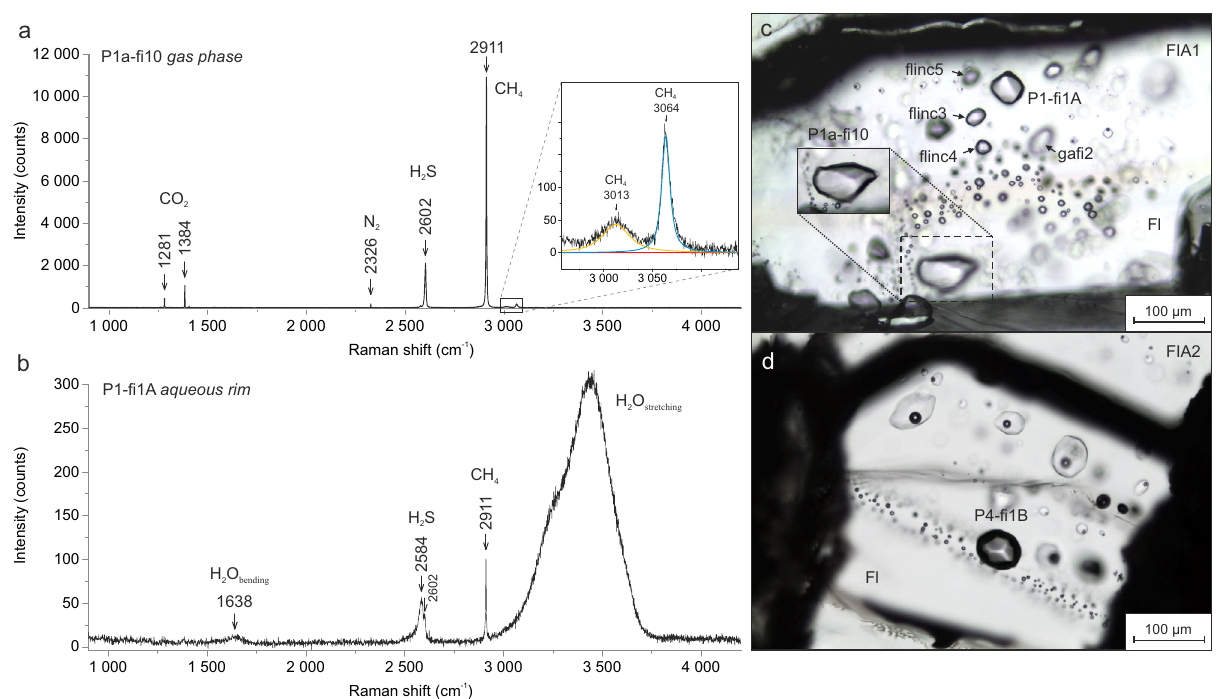
Fig. 1 Fluid inclusion assemblages (FIA ’ s) at room temperature. a Raman spectrum of the gas phase in the gas-rich fl uid inclusions shows sharp peaks typical of the gas mixture: CH 4 (2911 cm − 1 ), H 2 S (2602 cm − 1 ), CO 2 Fermi diad (1281 cm − 1 , 1384 cm − 1 ), and N 2 (2326 cm − 1 ), representing symmetric stretching vibrations ( ν 1 ) of the gas molecules. Weak intensity broad peak at 3013 cm − 1 is attributed to the triply degenerate anti-symmetric C – H stretching of CH 4 gas, whereas a weak 2 ν 2 overtone at 3064 cm − 1 is assigned to the doubly degenerate ν 2 mode vibration of CH 4 gas 49 . b Raman spectrum of the aqueous phase rim surrounding the gas phase. The broad Raman peak between 3000 and 3700 cm − 1 , and weak peak at 1638 cm − 1 correspond to stretching and bending vibrations in H 2 O, respectively. The low-intensity Raman band at 2584 cm − 1 is assigned to H 2 S dissolved in water. c